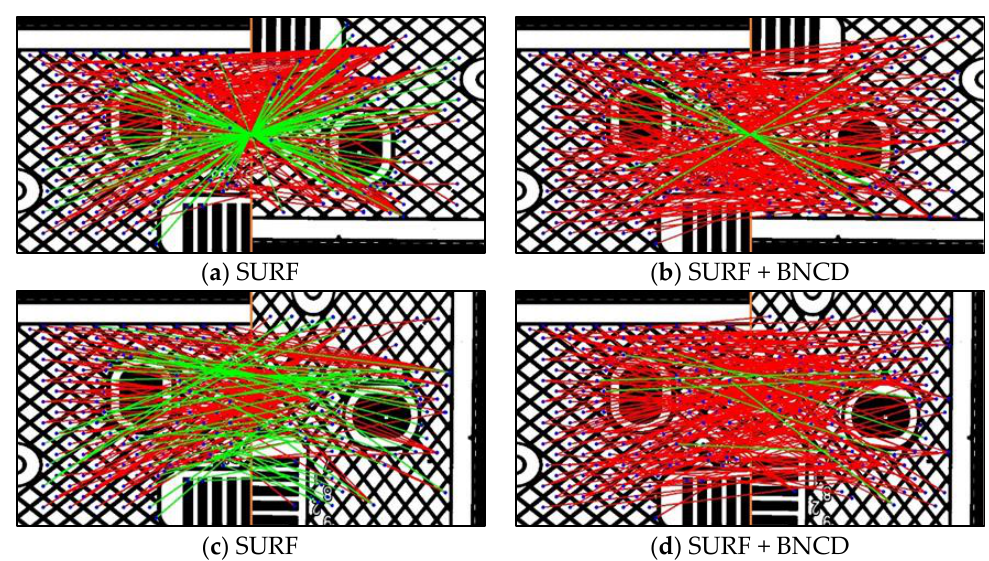
Figure 9. Cases where the BNCD fails. Green and red lines indicate correct and incorrect matches, respectively. ( a ) SURF matching result; matching precision rate is 29.5%. ( b ) SURF + BNCD matching result; matching precision rate is 4.5%. ( c ) SURF matching result; matching precision rate is 29.5%. ( d ) SURF + BNCD matching result; matching precision rate is 3.5%.